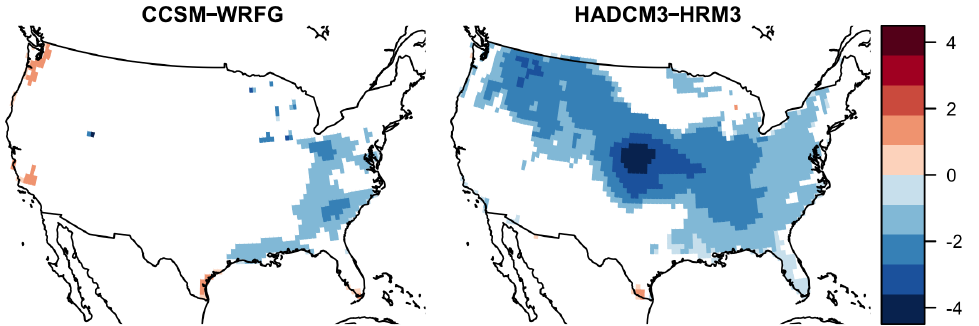
Figure 11. A heat map of the estimated average interaction effect for the IPL model. Only significant locations at the 0.10 level using the CoPE method are shown.